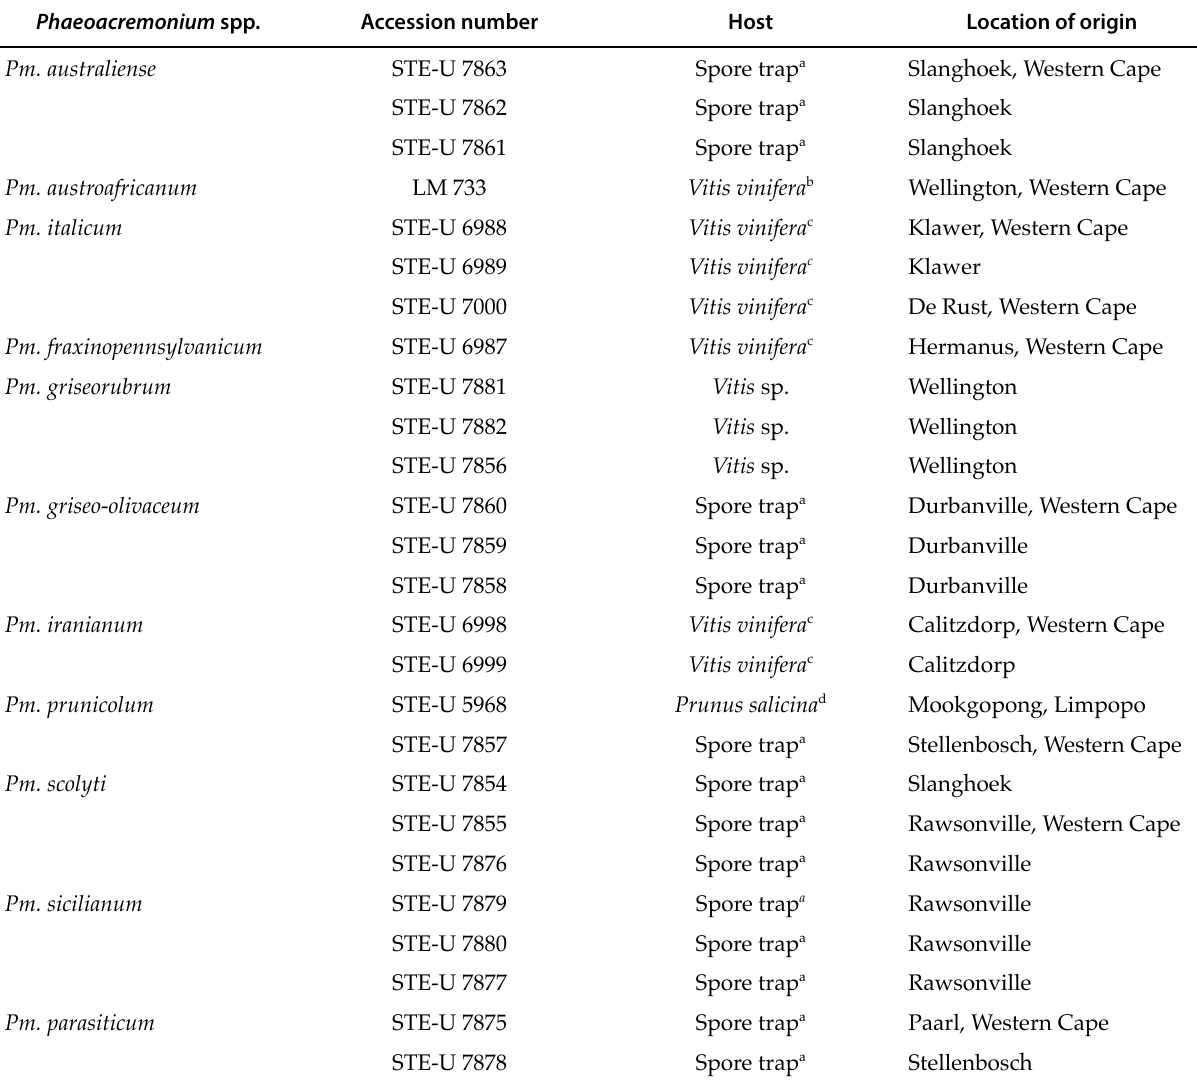
Table 1. Phaeoacremonium spp. and isolates used in the pathogenicity study. Phaeoacremonium